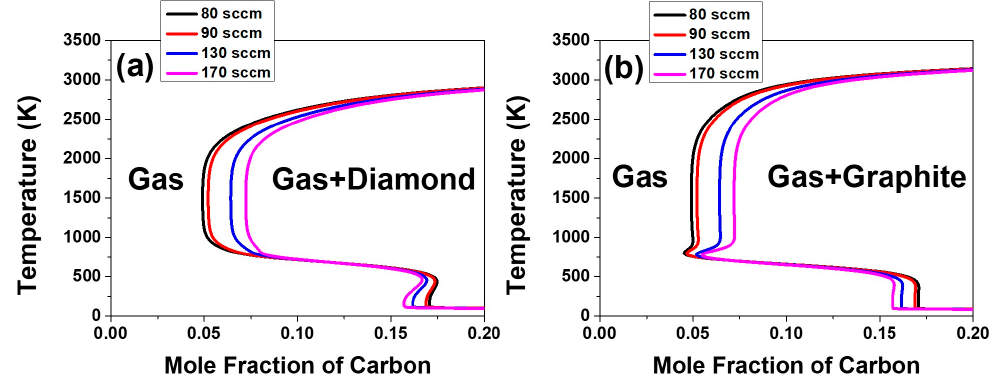
Figure 8. Equilibrium carbon solubility in the gas phase for ( a ) diamond and ( b ) graphite for acetone fluxes of 80, 90, 130 and 170 sccm at 4000 Pa as a function of temperature.